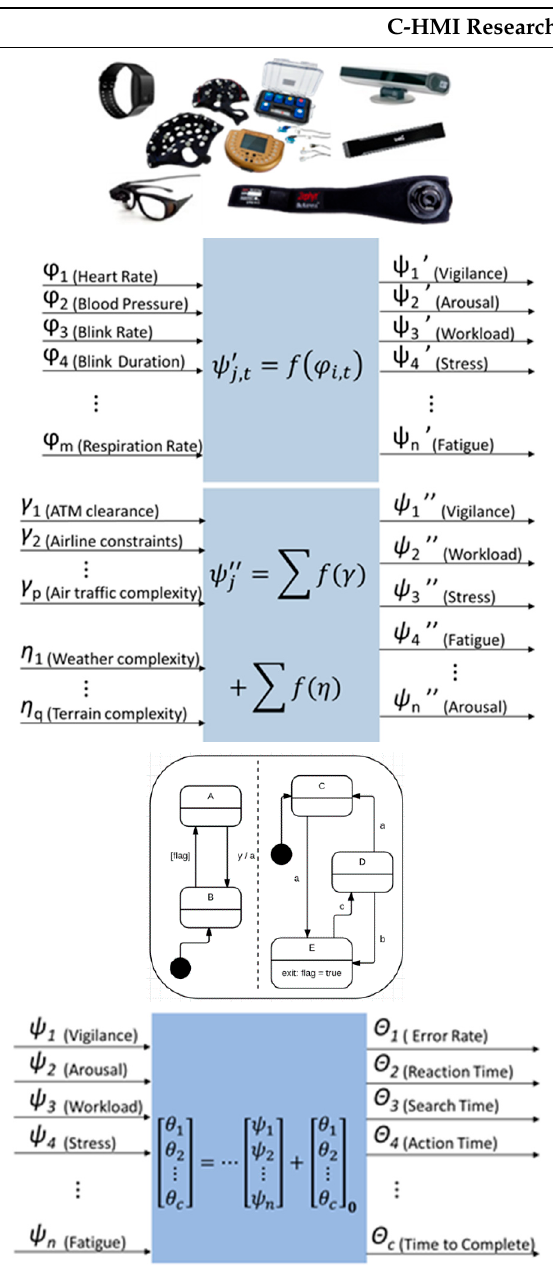
Table 6. The cognitive human–machine interface (C-HMI) research framework (from Reference [37]). NINA—neurometrics indicators for ATM; ANFIS—adaptive neuro-fuzzy inference